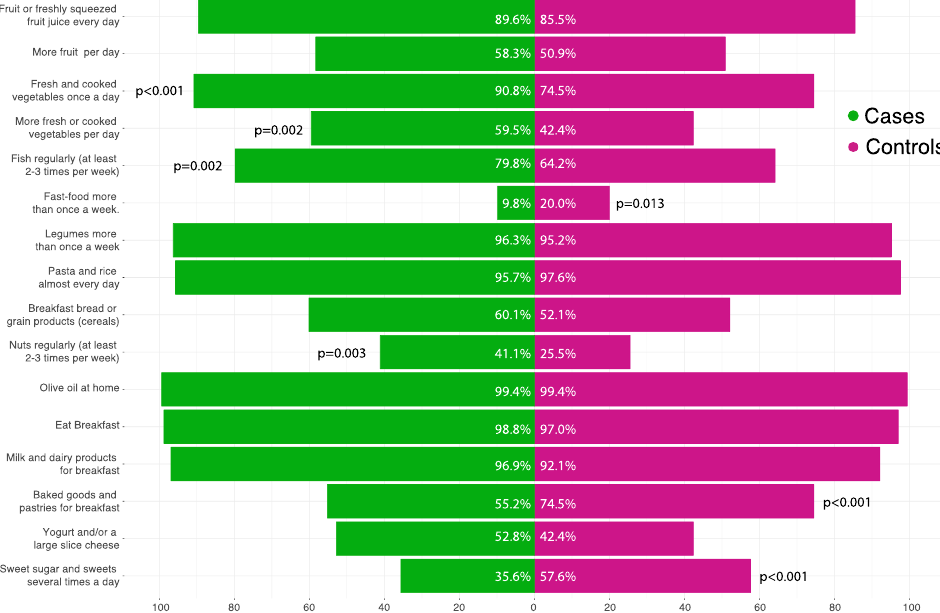
Figure 2. Differences between groups according to the single items of the KidMed questionnaire. Between groups differences for each item were assessed using the Chi square test without adjustment for multiple comparisons.